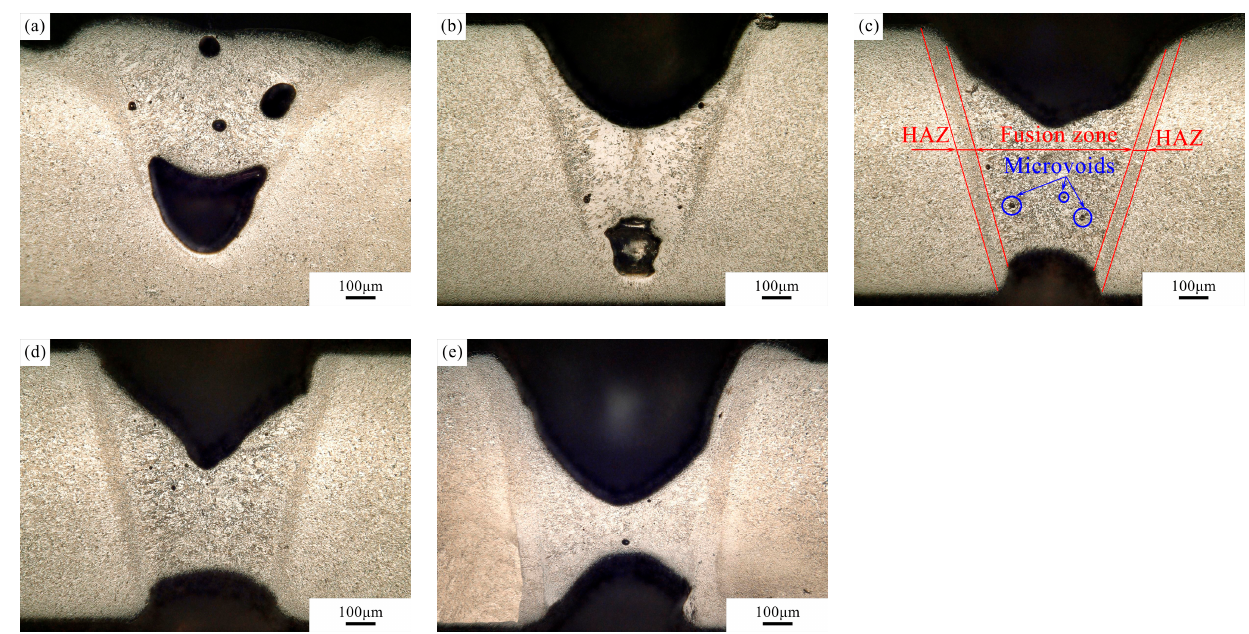
Figure 3. Optical micrographs of spots on the plate, with a power of 2500 W and a pulse duration of ( a ) 2 ms, ( b ) 2.5 ms, ( c ) 3 ms, ( d ) 3.5 ms and ( e ) 4 ms.